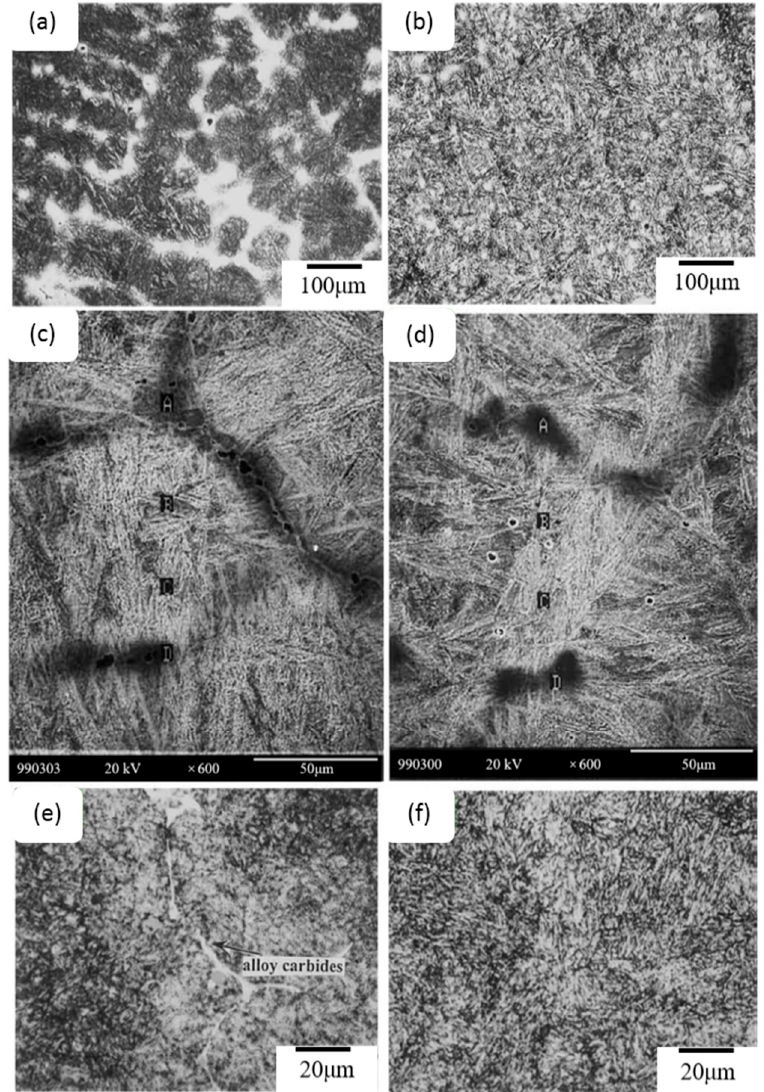
Figure 5. Cast microstructures of ( a ) CH13 steel and ( b ) MCH13 steel. Interdendrite areas of ( c ) CH13 steel and ( d ) MCH13 steel. Tempered microstructures of ( e ) CH13 steel and ( f ) MCH13 steel [49].